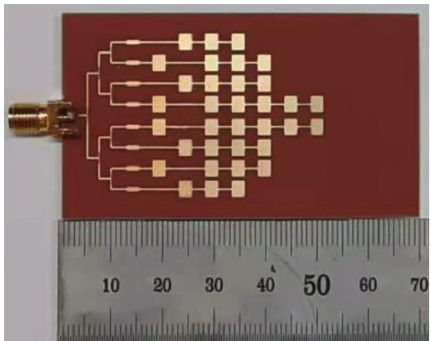
Figure 14: Photograph of fabricated 34 elements thinned array